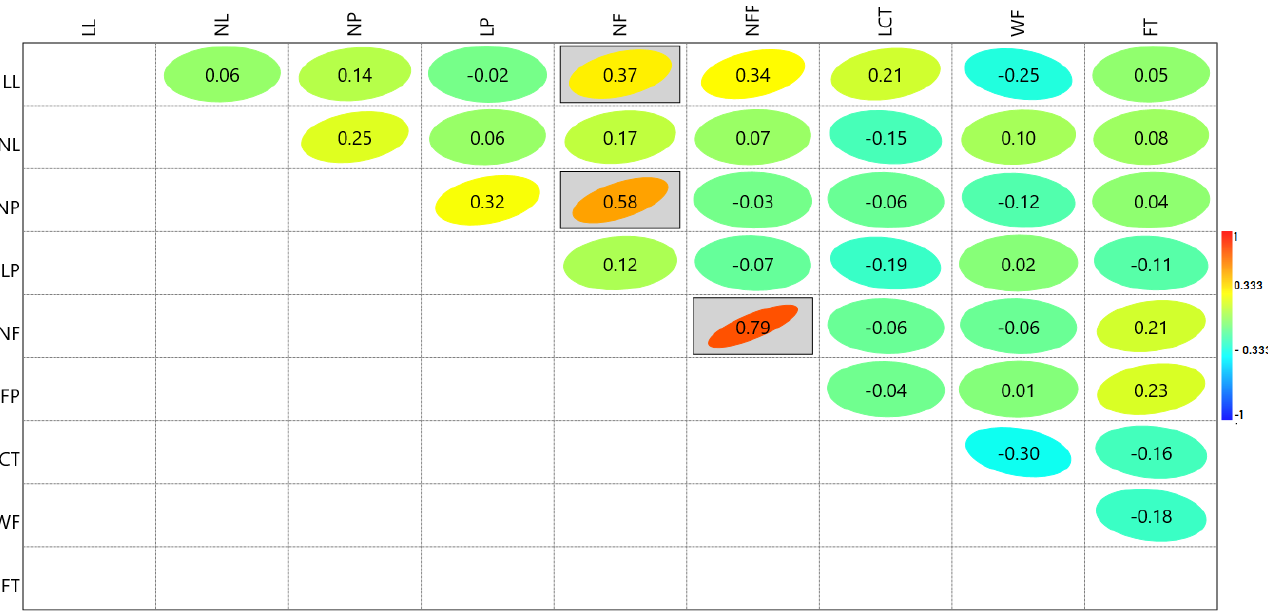
Figure 4. Pearson correlation coefficients (‘r’ value) between the mean values of the morphological parameters of F 1 plants from P2×P1 cross. LL—length of leaf (cm); NL—number of leaves; NP—number of peduncle/plant; NF—number of flowers/plant; NFP—number of flowers/peduncle; LCT—length of corolla tube (cm); WF—width of flower (cm); FT—flowering time (days). The color intensity of the ellipses is directly correlated to the correlation coefficient value. The boxes with a grey border illustrate statistically assured values of “r” at a p -level below 0.05.